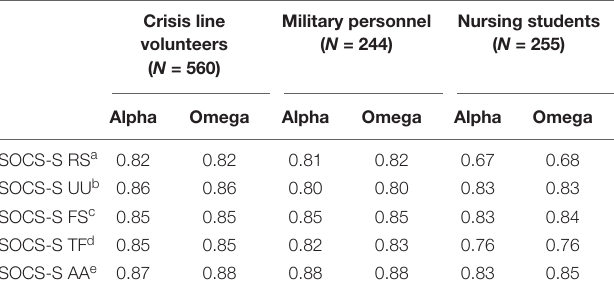
TABLE 3 | Cronbach’s alpha and McDonald’s omega total coefficients for SOCS-S subscales in all validation